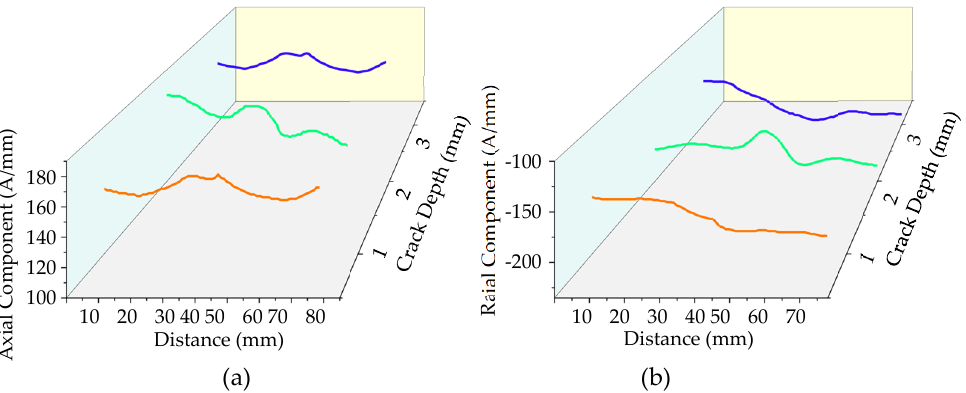
Figure 16. The weak magnetic signal of pipeline crack with different crack depths: ( a ) axial component and ( b ) radial component.